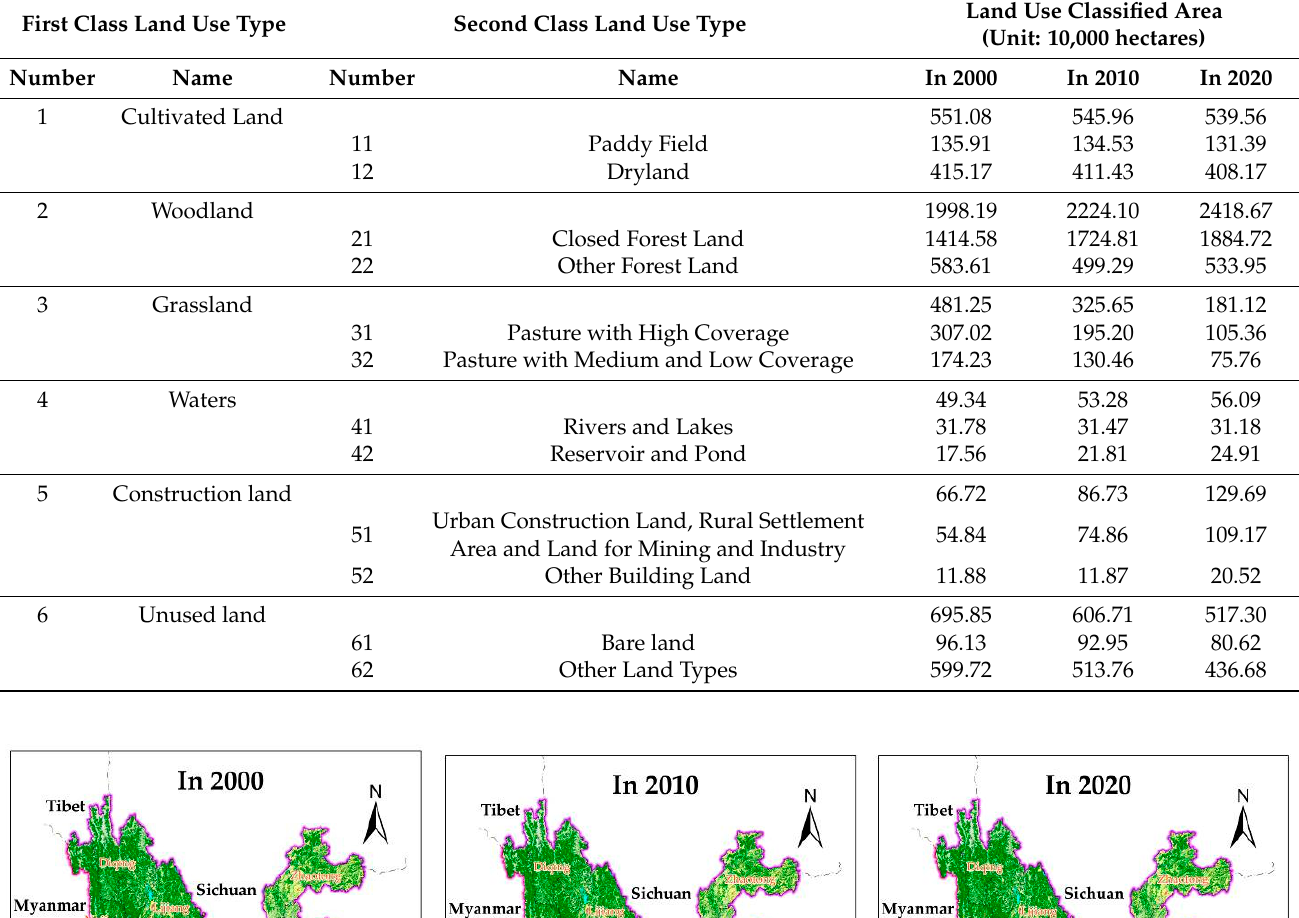
Table 1. The classified area of land use in 2000, 2010 and 2020.